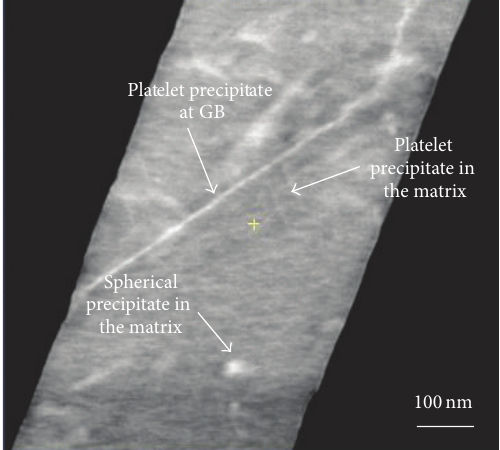
Figure 2: High angle annular bright field scanning transmission electron microscopy image showing the heterogeneous formation of a bright imaging platelet precipitate at the grain boundary and the distribution of platelets and spherical precipitates within the